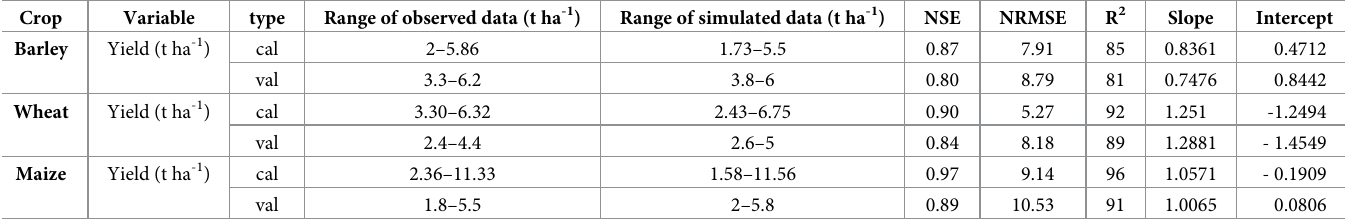
Table 5. Statistical criteria for calibration of